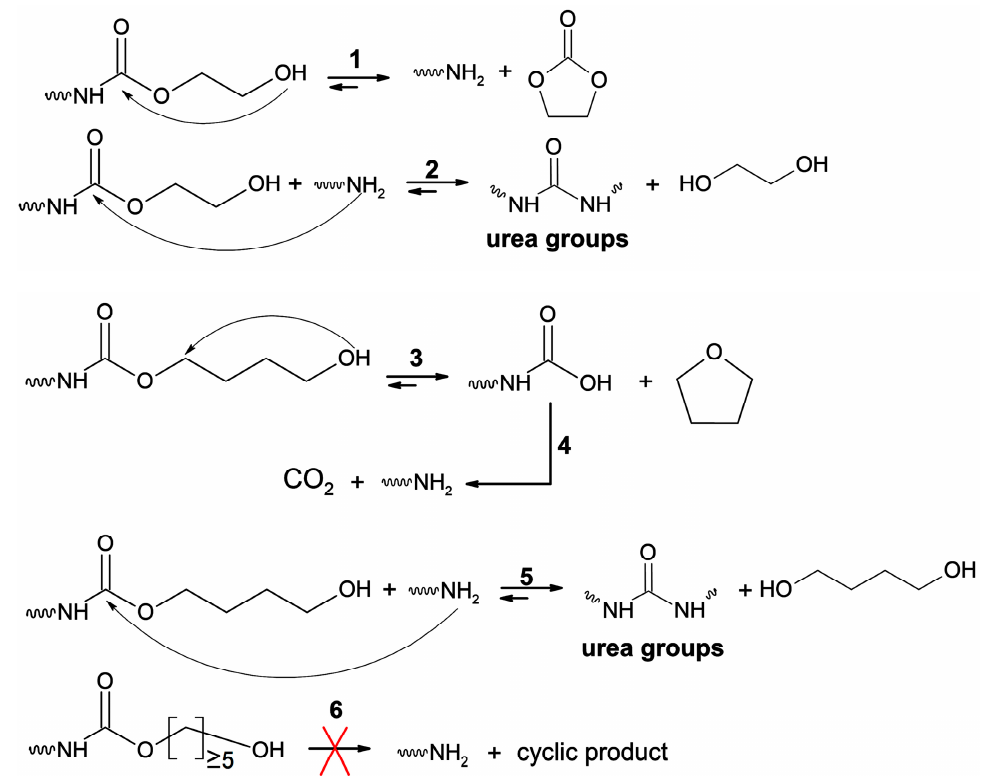
Figure 2. The dependence of the hydrocarbon chain length in the terminal groups of BHACs on the tendency to the formation of urea groups via the back-biting side